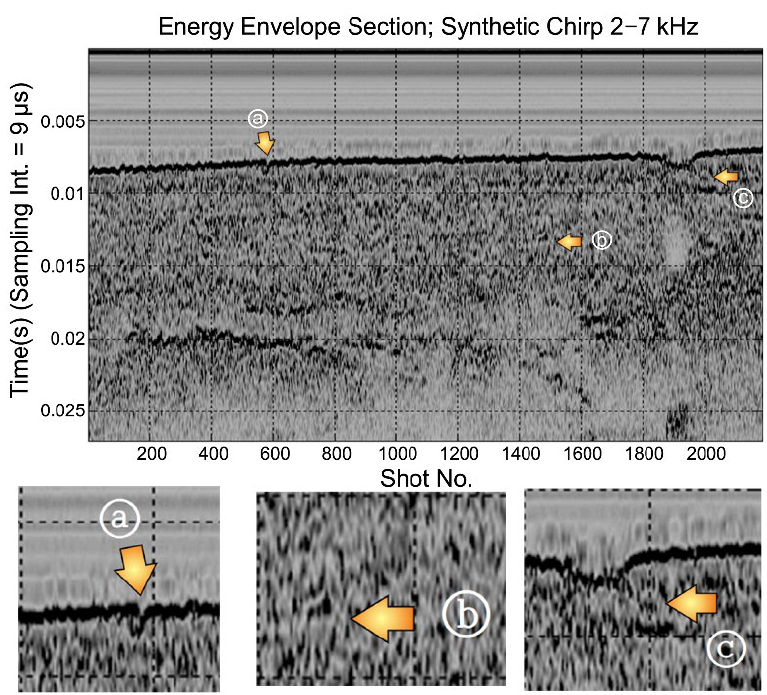
Figure 12. Chirp sub-bottom profiler (SBP) envelope section generated with Source I.